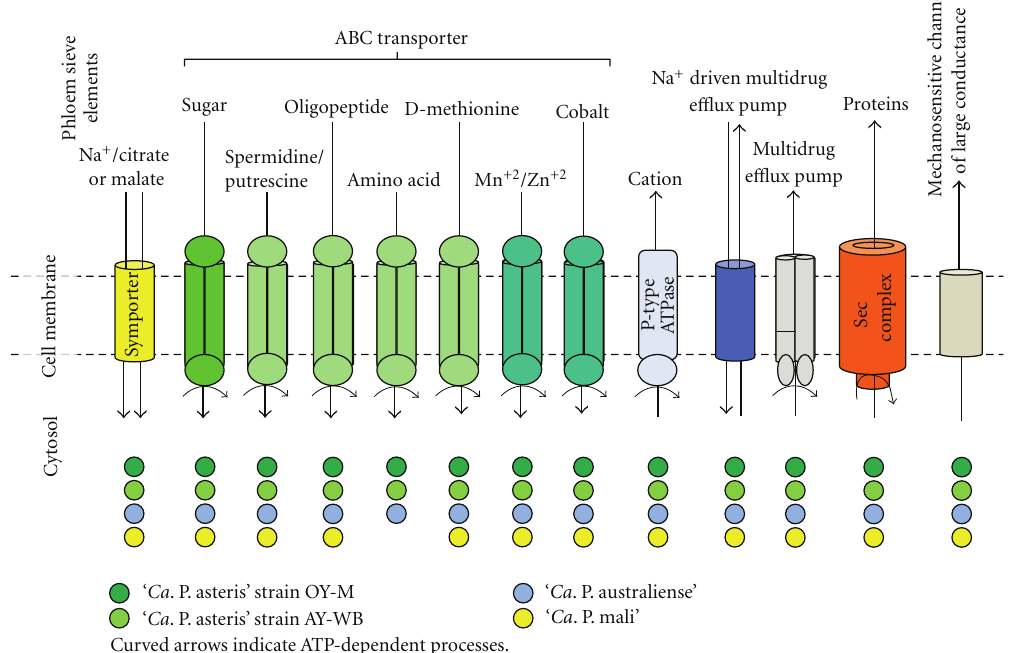
Figure 6: Symporter, transporter, ion translocation, and